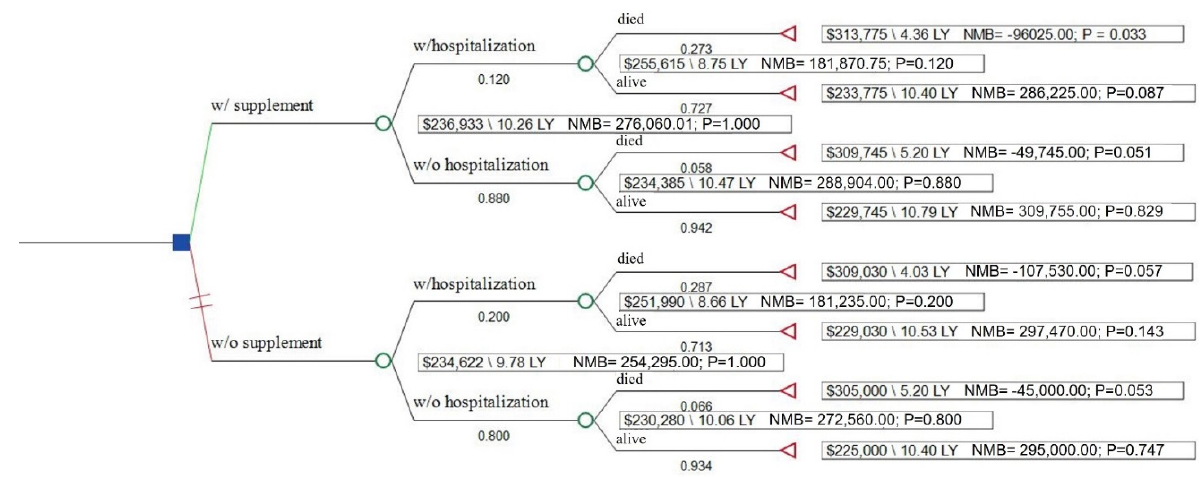
Figure 1. Decision tree analysis of cost-effectiveness of dietary supplementation. LY, life years; NMB, net monetary benefit.